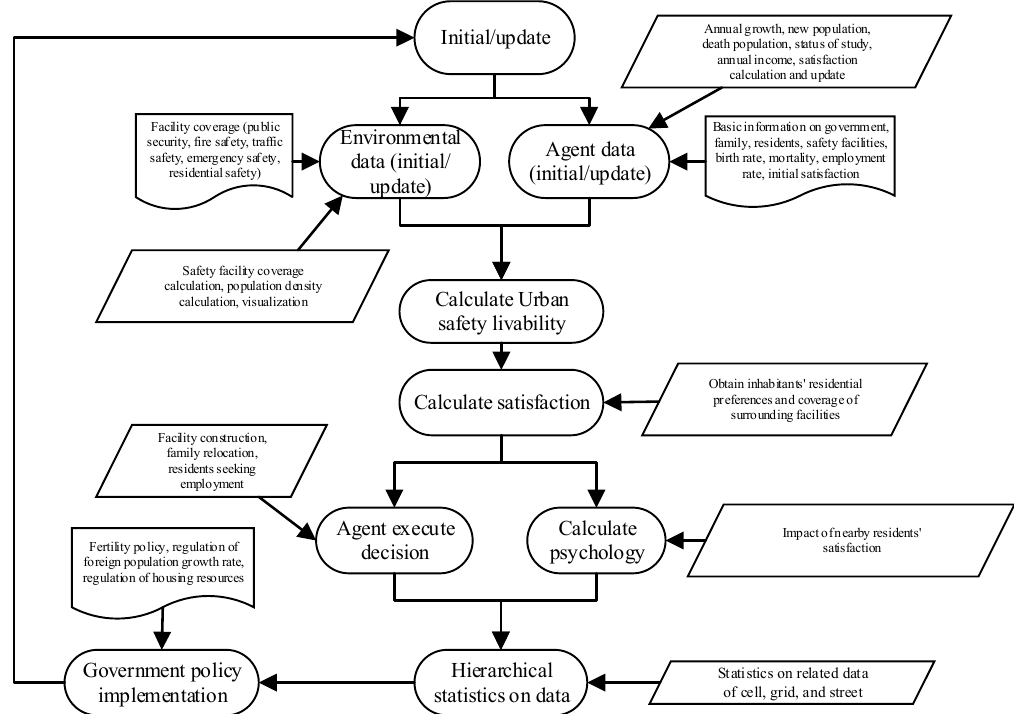
Figure 6. Model calculation process.